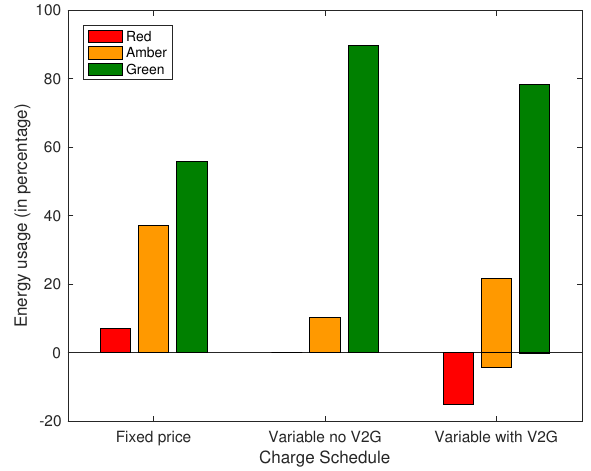
Figure 10. Energy usage across tariff regimes for utility PEVs.